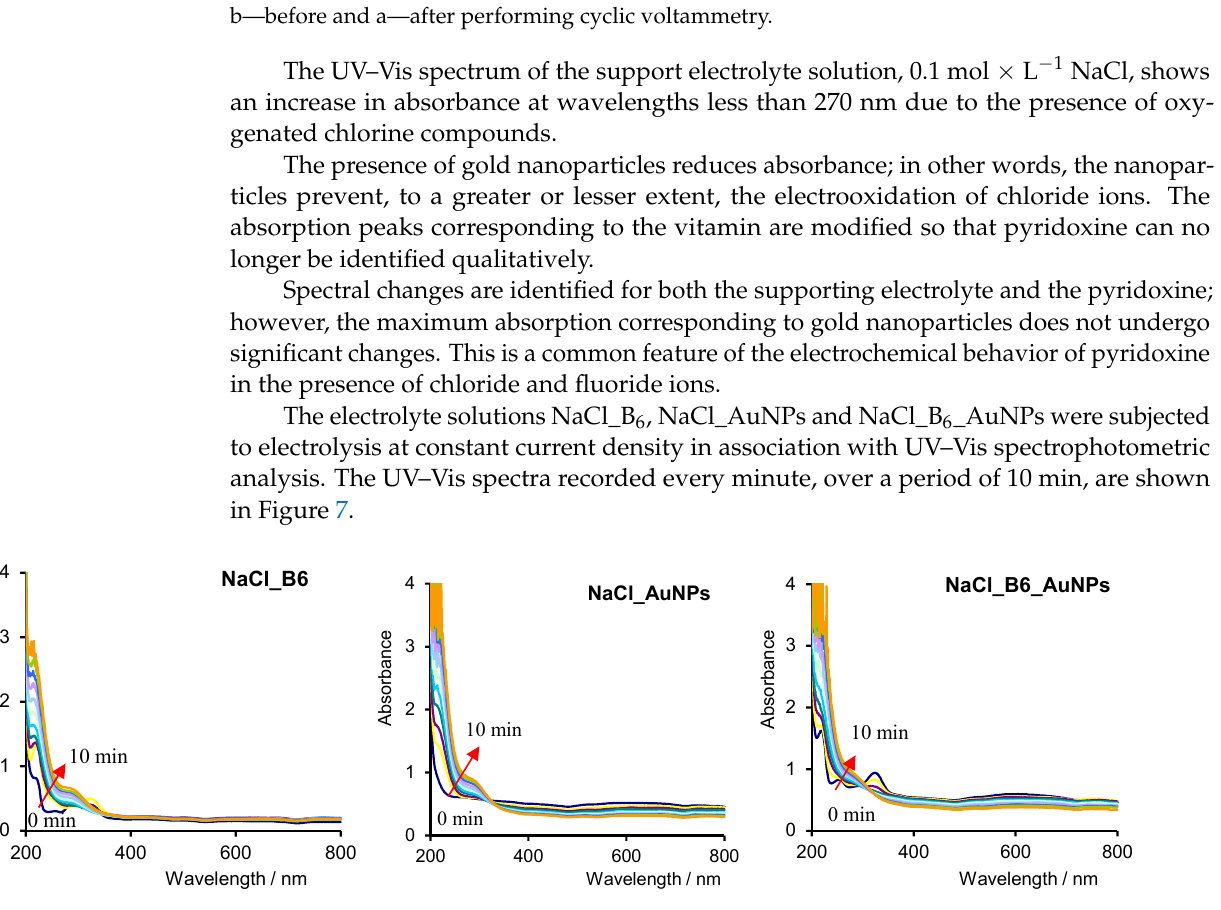
Figure 7. UV–Vis absorption spectra of sample as the electrochemical processes progress over time in NaCl/B 6 /AuNP systems (i = 50 mA × cm − 2 ).